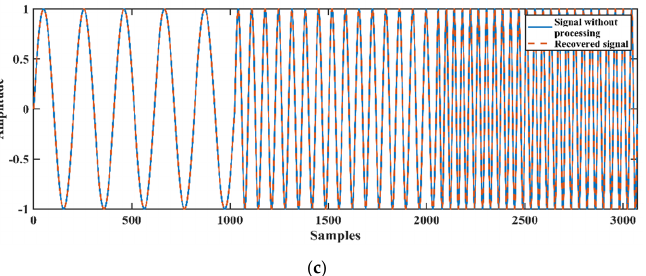
Figure 3. Processed and recovered signals. ( a ) Sine function with color blue and recovered with color orange, absolute error in the recovery of 1.55 × 10 − 15 . ( b ) Pulse train with color blue and recovered with color orange, absolute error in recovery of 4.44 × 10 − 16 . ( c ) Non-stationary function with color blue and recovered with color orange, absolute error in the recovery of 1.63 × 10 − 15 .